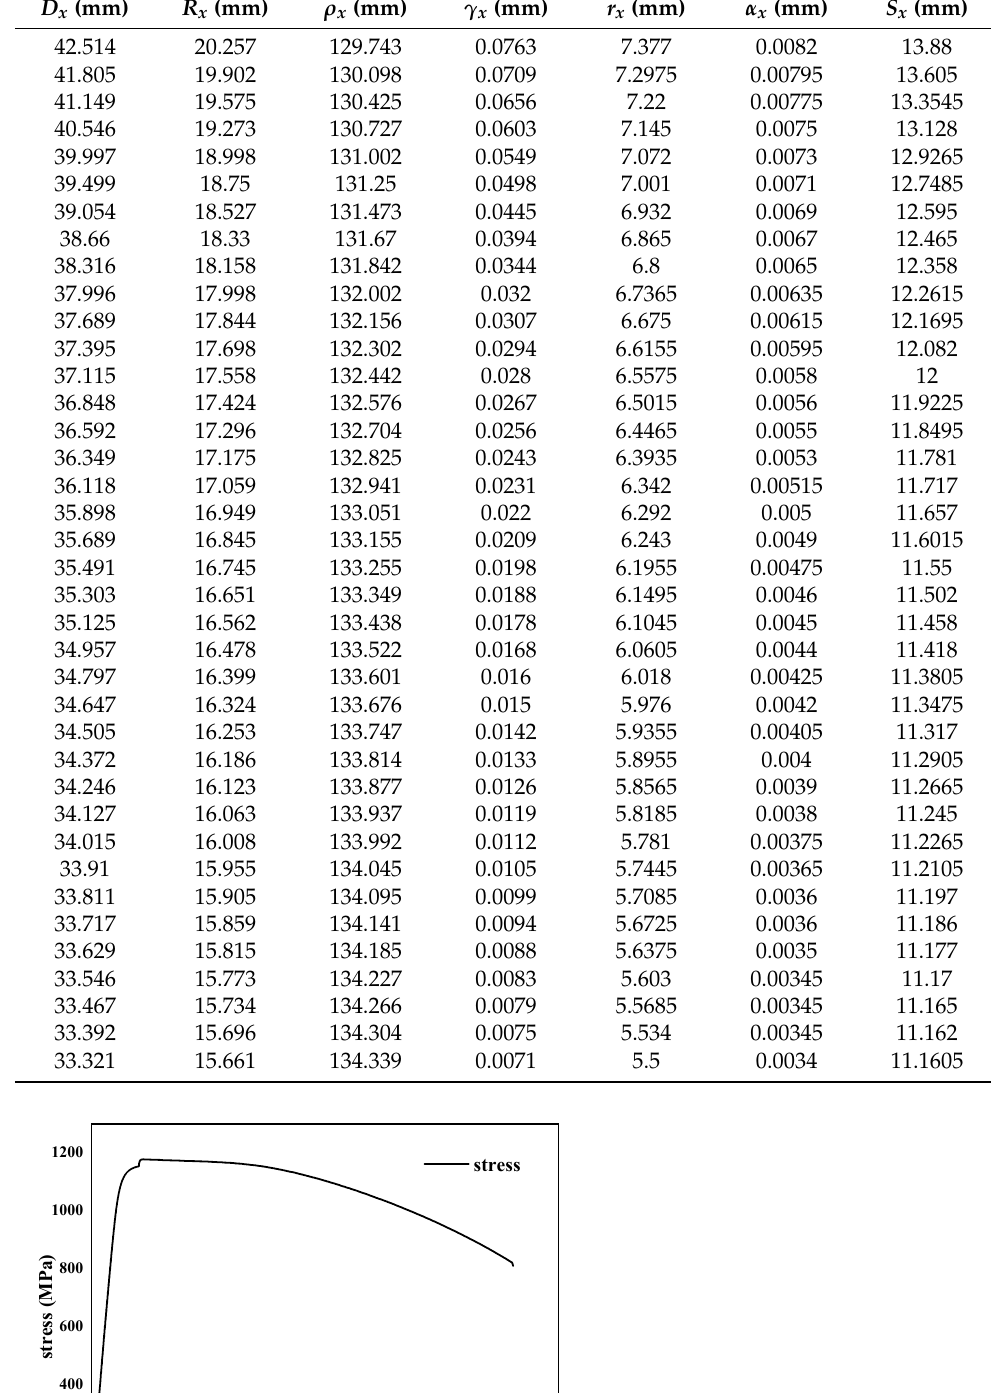
Table 5. The value of variable.